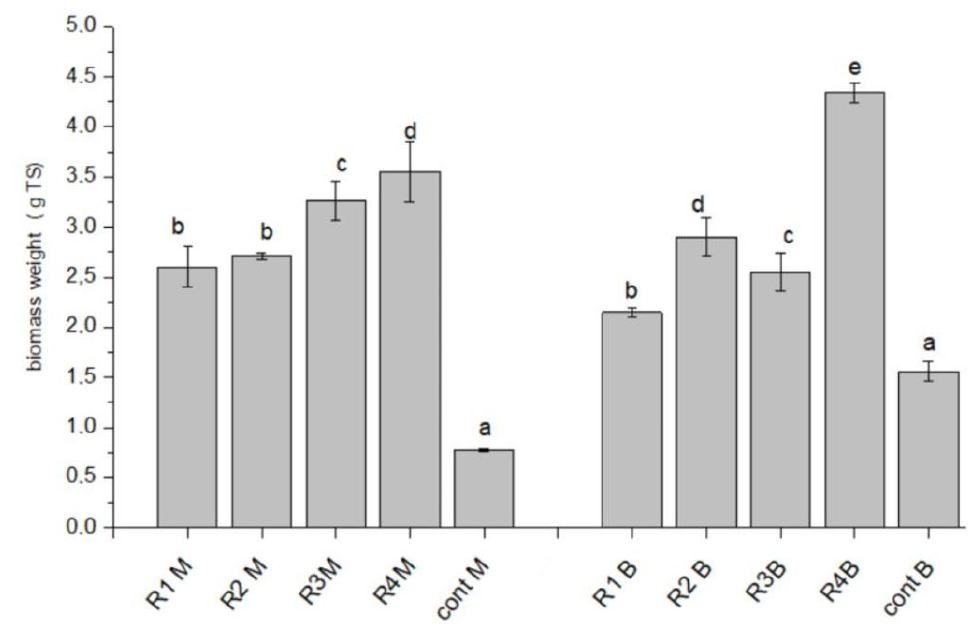
Figure 6. Fescue biomass M soil from the zinc smelter area. B soil from the lignite mine dumping site; bars with different letters are statistically different (Tukey’s test) .